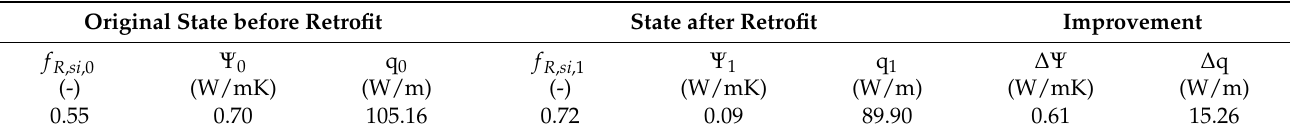
Table A7. Quantifiable results of the thermal bridge retrofit of a floor slab (ThermCad thermal bridge simulation calculation). Original State before Retrofit